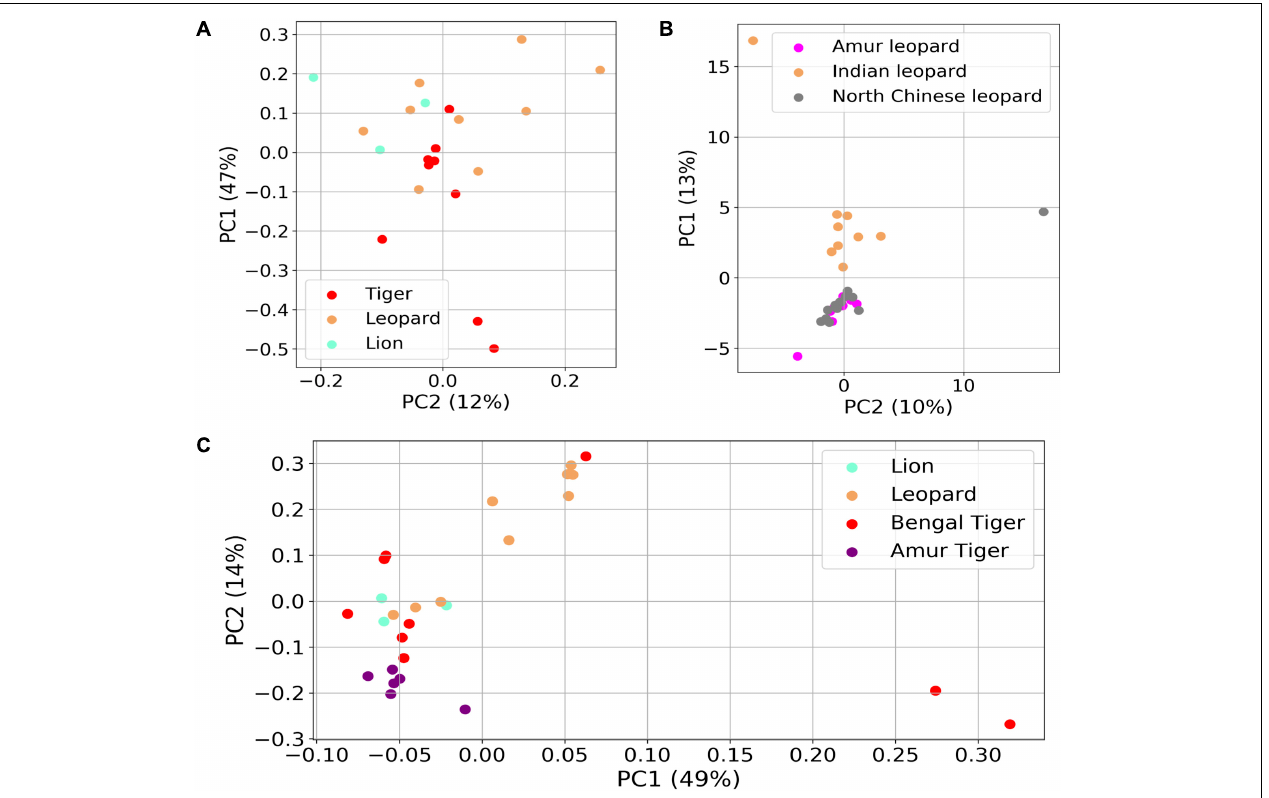
FIGURE 6 | Differences in the fecal microbial communities of Panthera species using dimensionality reduction methods. (A) Principal coordinates analysis (PCoA) plot of weighted UniFrac distances of gut bacteria of the 21 individuals. (B) Principal component analysis (PCA) plot of gut bacterial composition of Indian leopard (this study), Amur, and North Chinese leopards (data from previous studies). (C) PCoA plot of Hellinger distances calculated using functional profile [Kyoto Encyclopedia of Genes and Genomes (KEGG) Orthologs] in the 21 Panthera individuals (this study) and six Amur